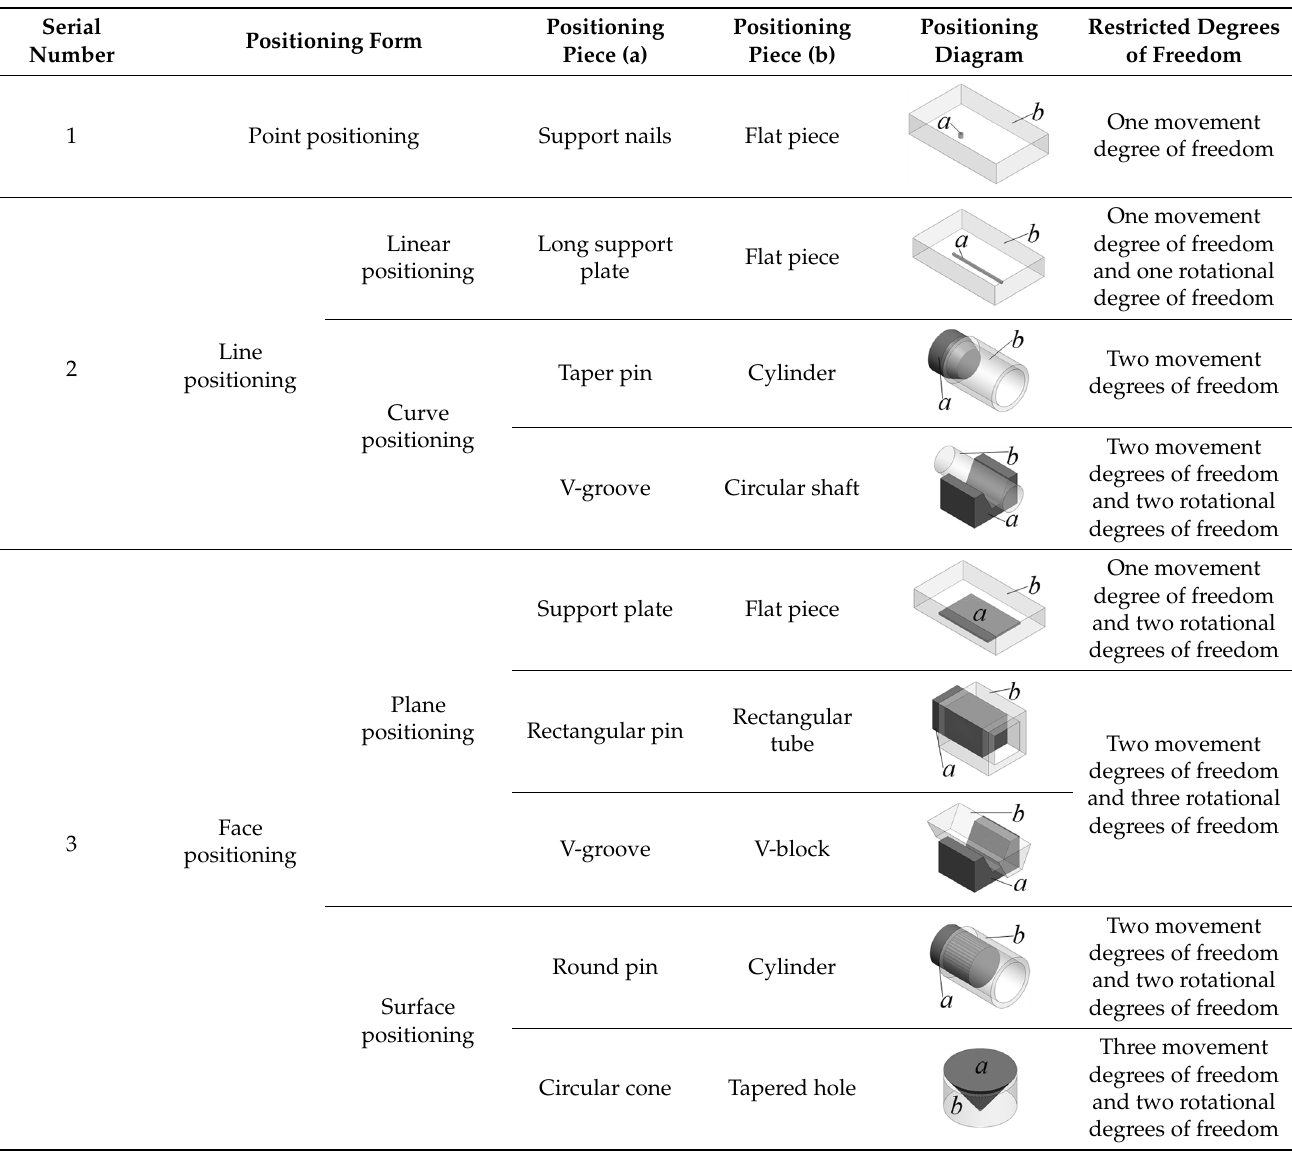
Table 1. Summary of common positioning Table 1. Summary of common positioning methods. Table 1. Summary of common positioning methods. Table 1. Summary of common positioning methods. Table 1. Summary of common positioning methods. Table 1. Summary of common positioning methods. Table 1. Summary of common positioning methods. Table 1. Summary of common positioning methods. Table 1. Summary of common positioning methods. Table 1. Summary of common positioning methods.